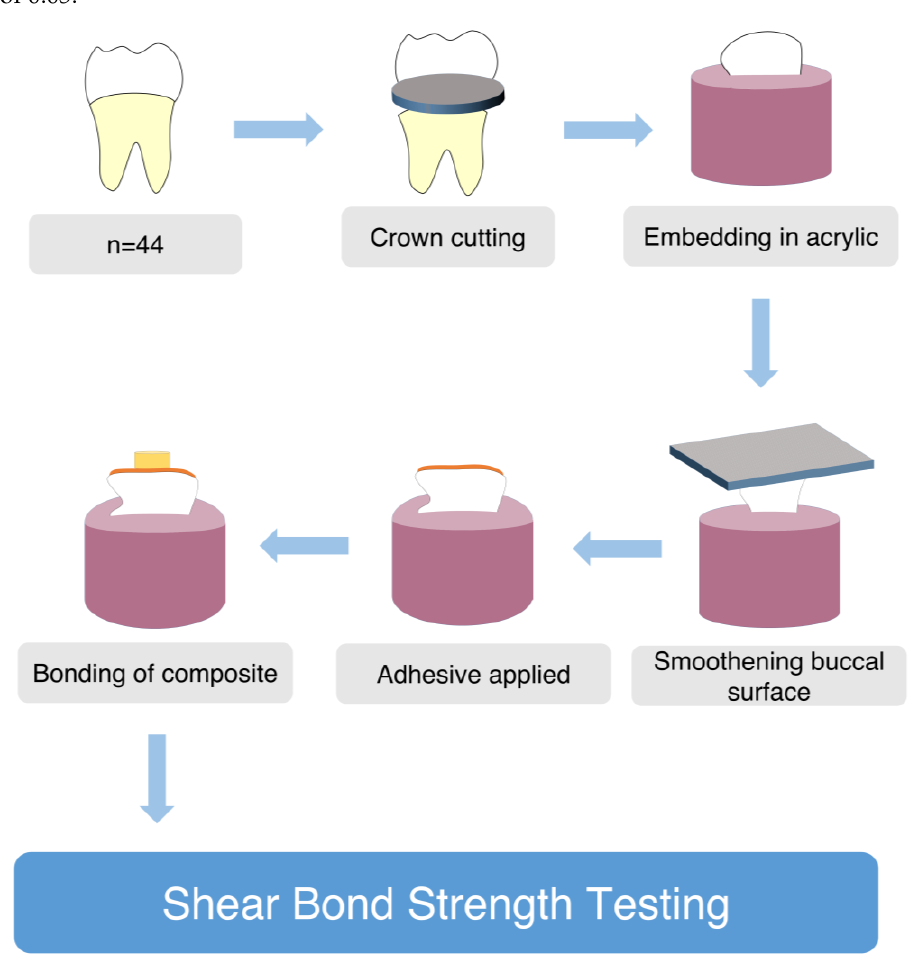
Figure 1. Preparation of specimens for Shear Bond Strength testing.